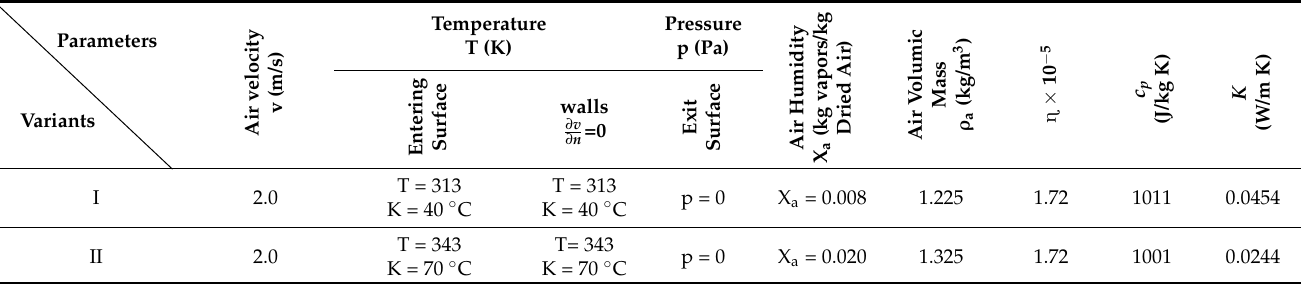
Table 2. Processing imposed conditions for the drying agent.